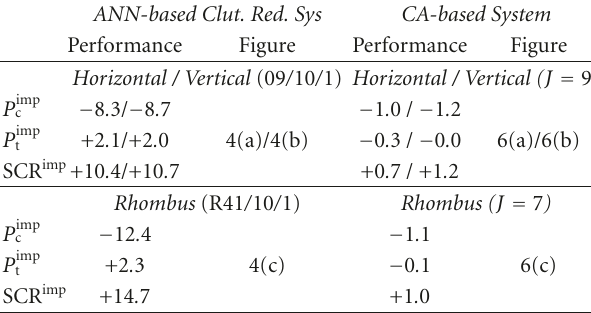
Table 4: Performance improvements achieved by the CA and ANN- based clutter reduction systems for the radar image under study of Figure 3. ANN-based Clut. Red. Sys Horizontal / Vertical (09 / 10 / 1) Horizontal / Vertical ( J = 9